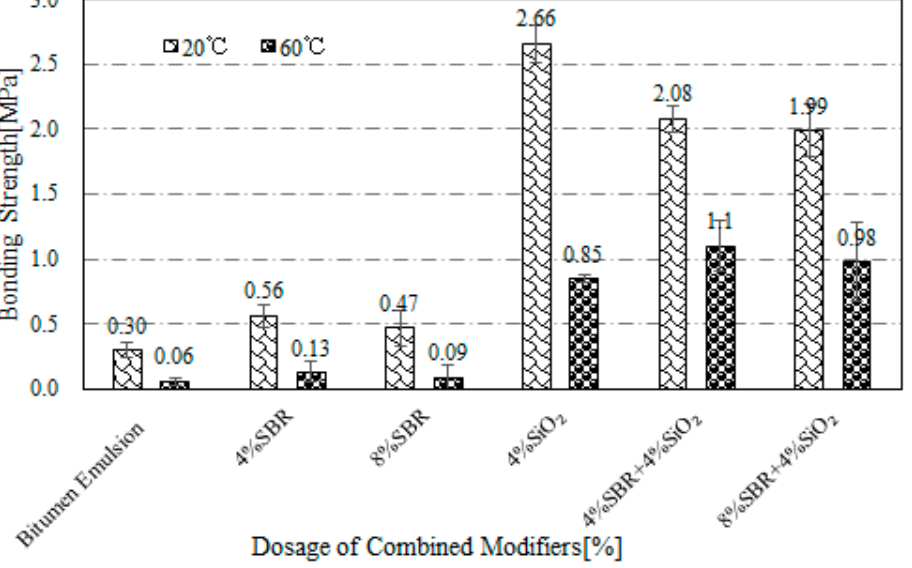
Figure 5. Bonding strength of SBR + SiO 2 -modified bitumen emulsion.